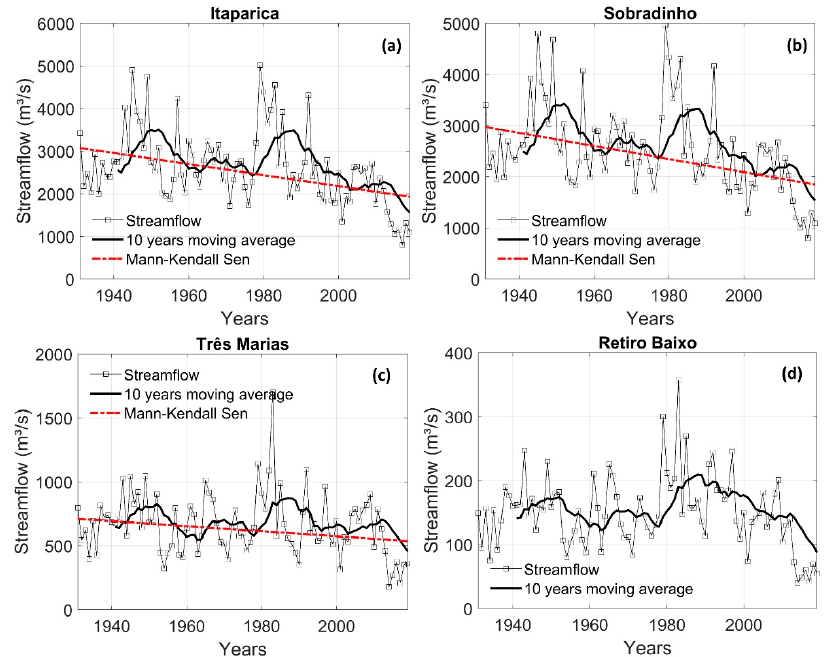
Figure 8. Historical annual estimation of Brazilian National Electrical System Operator (ONS) series of naturalized flow with 10-year moving average and Mann–Kendall Sen trend test (from 1931 to 2019); ( a ) Itaparica, ( b ) Sobradinho, ( c ) Três Marias and ( d ) Retiro Baixo.